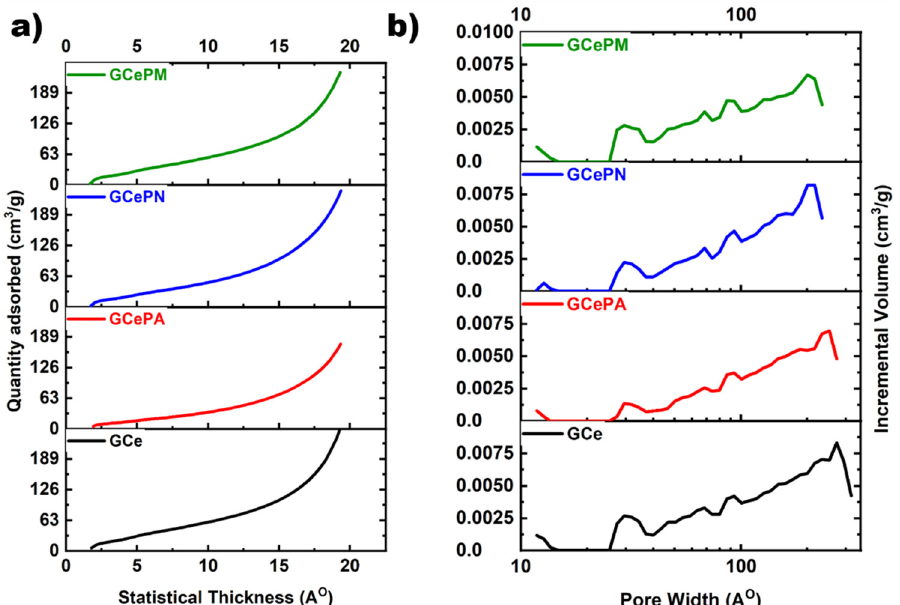
Figure 11. ( a ) Determination of the microporous and mesoporous material based on t-plots for GCe (black), GCePA (red), GCePN (blue), and GCePM (green). ( b ) Incremental pore volume vs. pore width for GCe (black), GCePA (red), GCePN (blue) and GCePM (green).